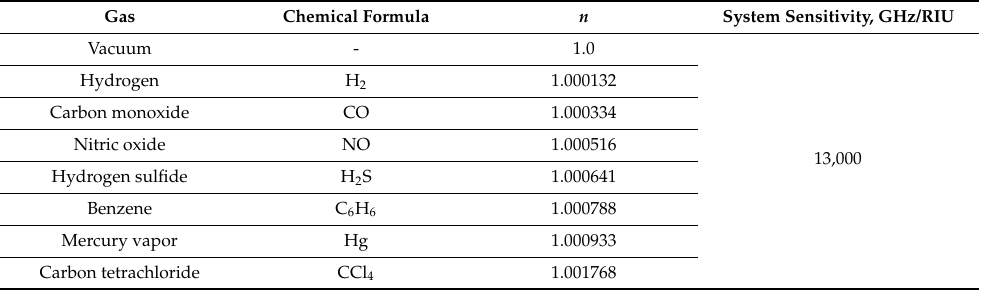
Table 5. System sensitivity for frequency interrogation.